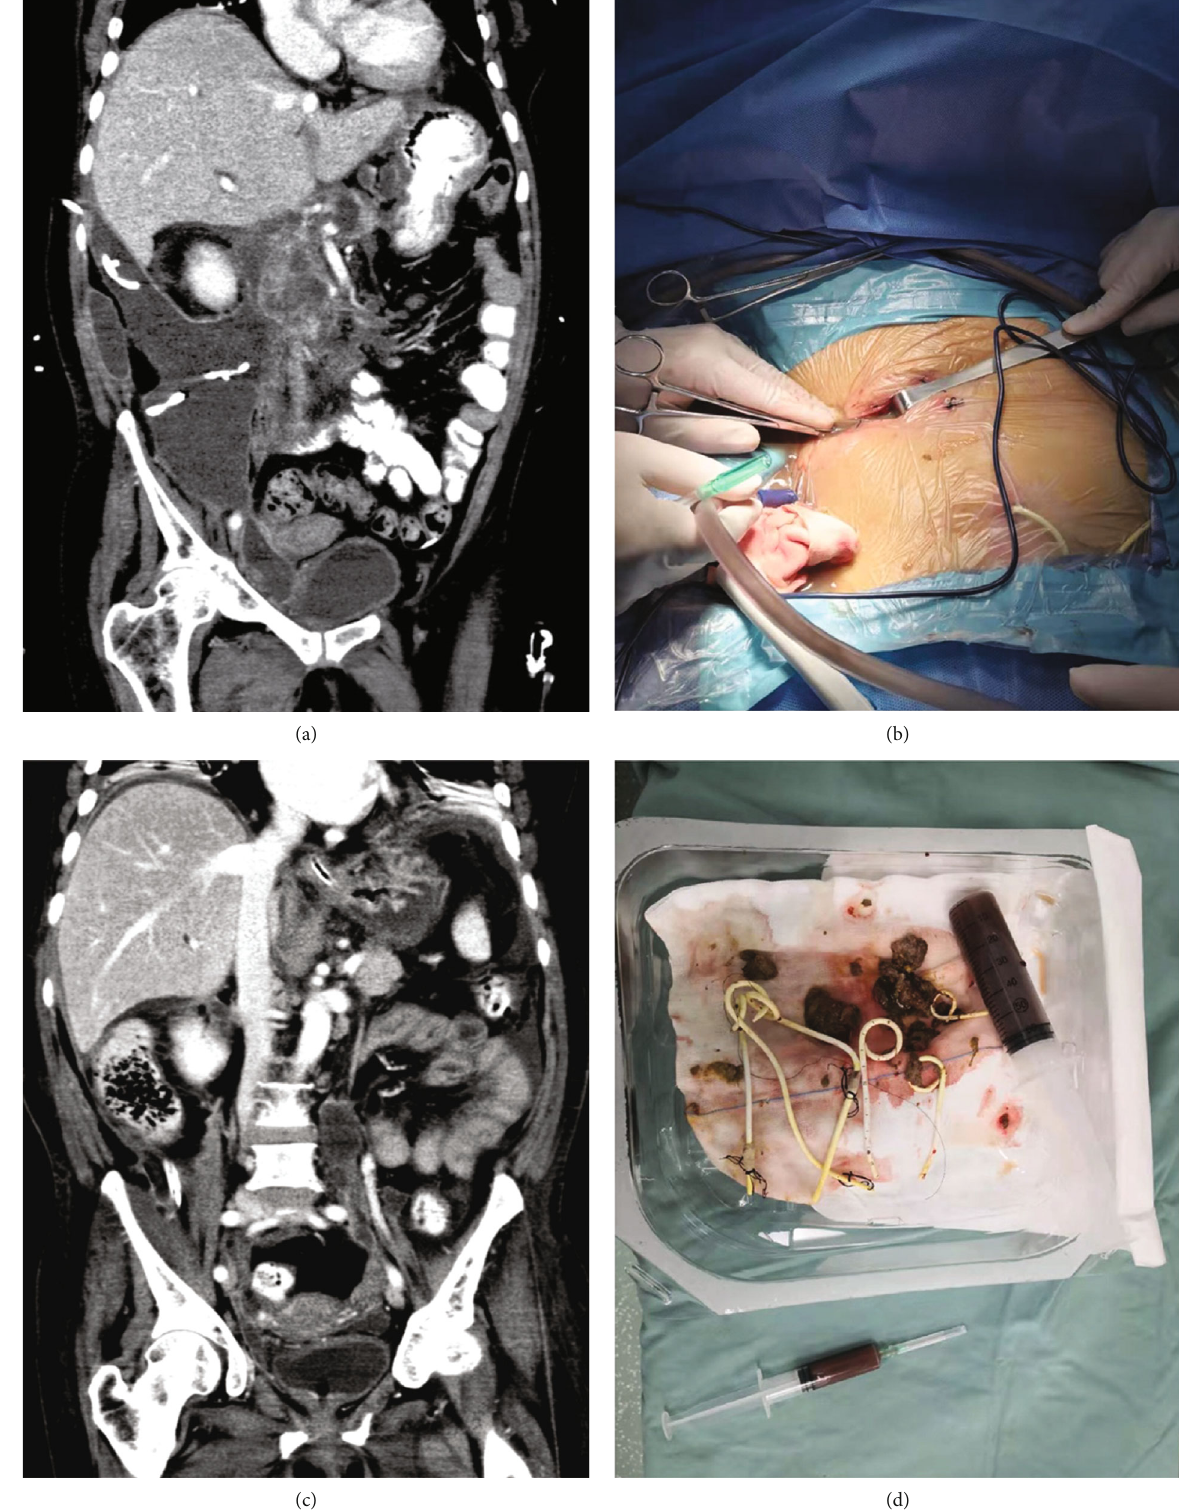
Figure 1: Small incision combined with nephroscope surgery for infectious pancreatic necrosis. (a) Preoperative CT showed a large amount of necrosis in the pancreas and intestinal space. (b) Incision of the transretroperitoneal approach surgery. (c) Postoperative CT showed that the necrosis was basically removed and absorbed. (d) Necrosis and exudates